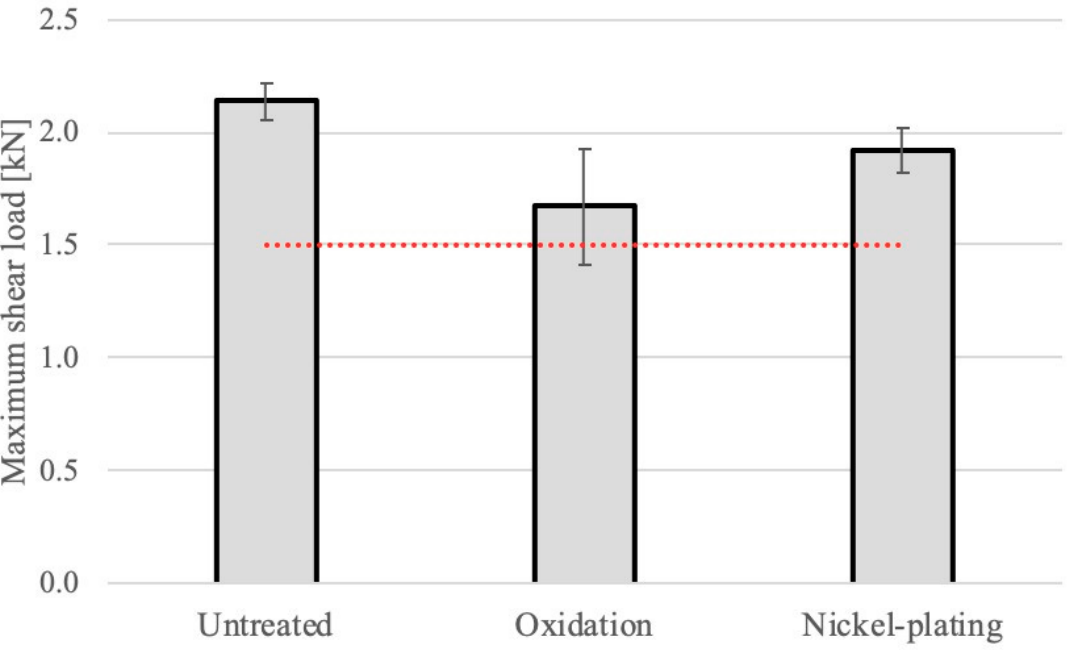
Figure 9. Maximum shear strength of steel RJS specimens coated by oxidation and nickel-plating, compared with reference untreated specimens. The red dotted line represents the threshold value for the RJS specimen’s minimum allowed joint strength (1.5 kN).